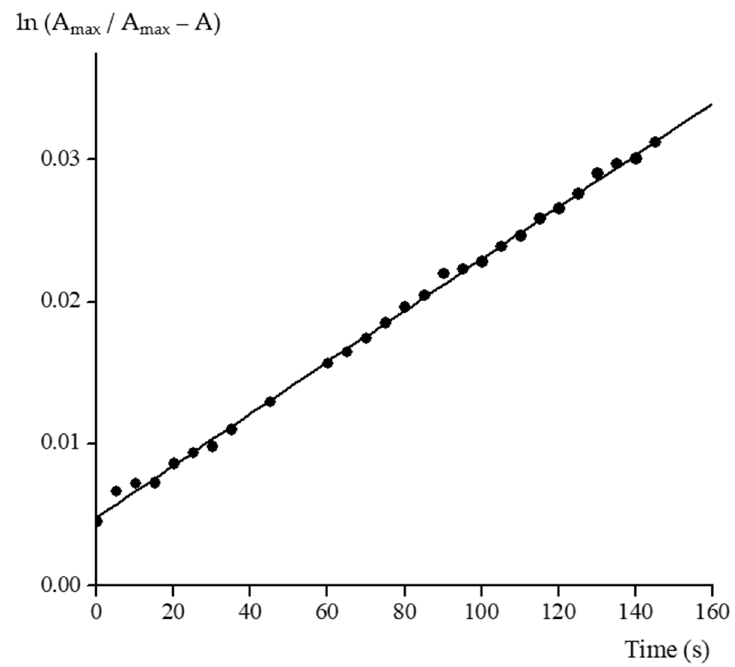
Figure 4. Example of an experimental determination of the synthesis reaction rate constant k s